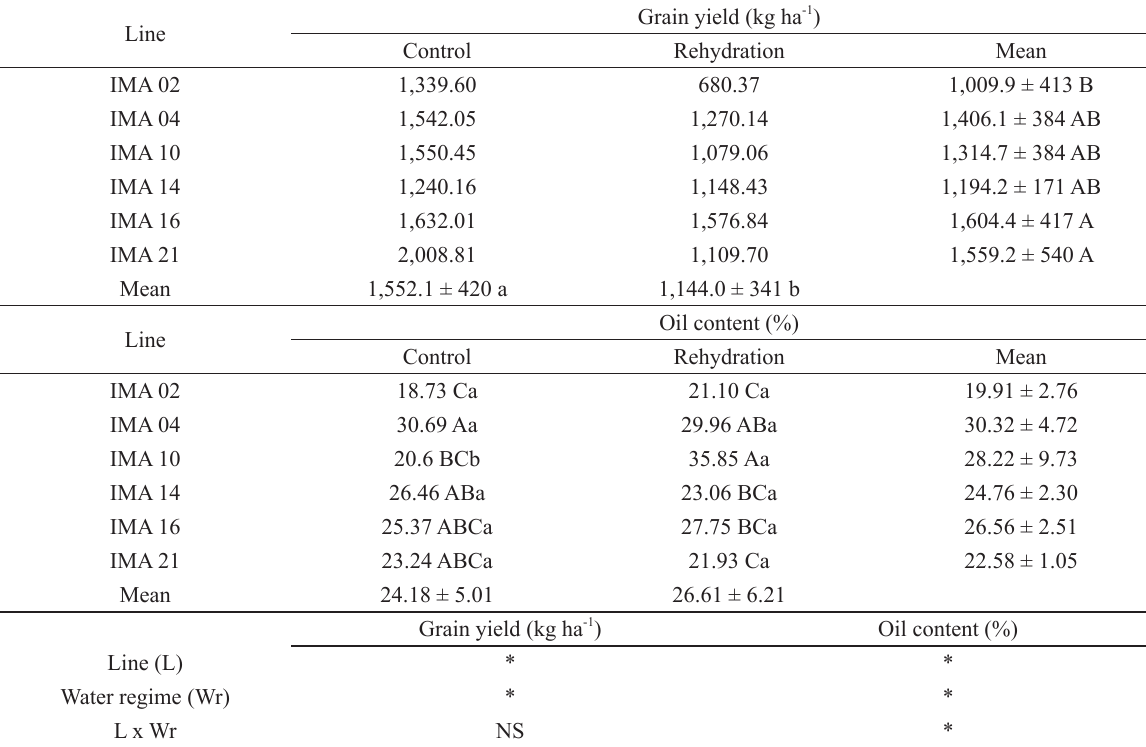
Effect of water deficit and rehydration on grain yield and oil content of six safflower lines in Botucatu – São Paulo,